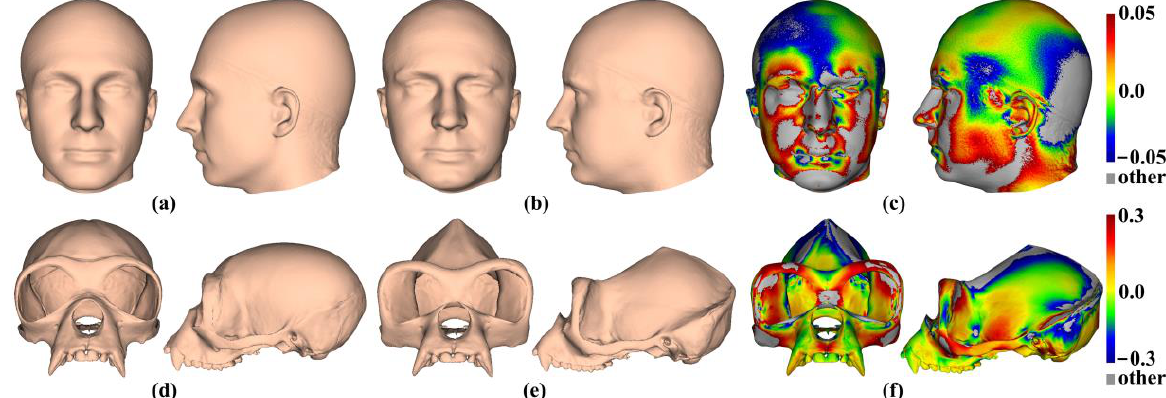
Figure 26. ( a ) Allometric prediction of mean head surface at the sample minimum centroid size using the template surface, estimated using landmarks and 1000 semilandmarks from sliding TPS. ( b ) Allometric prediction of mean head surface at the sample minimum centroid size using the surface of the head with minimum Procrustes distance to the mean warped using landmarks alone. ( c ) Colour map between surfaces a (reference) and b (target). ( d ) Allometric prediction of mean ape surface at the sample minimum centroid size using the template surface, estimated using landmarks and 800 semilandmarks from sliding TPS. ( e ) Allometric prediction of mean ape surface at the sample minimum centroid size using the ape cranium used to generate the template, estimated using landmarks alone. ( f ) Colour maps between surfaces d (reference) and e (target) using different ranges.